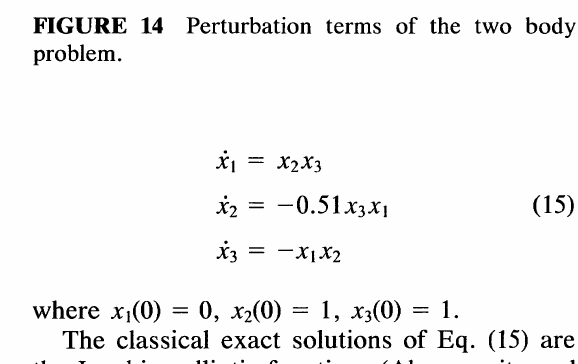
FIGURE 14 Perturbation terms of the two body problem.